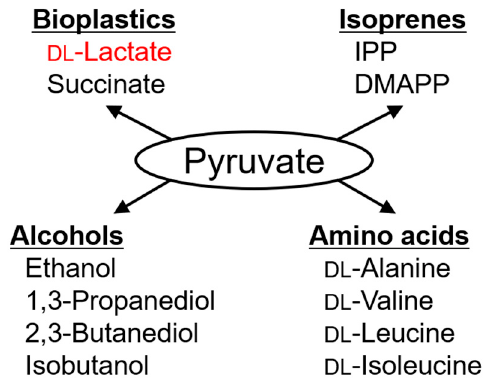
Figure 1. Derivatives of pyruvate. IPP and DMAPP indicate isopentenyl diphosphate and dimethylallyl pyrophosphate, respectively.